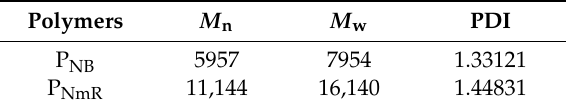
Figure 1. Characterization of fluorescent polymers. ( a ) Absorption spectra of the fluorescent polymers; ( b ) temperature-dependent for the fluorescent polymers in aqueous solution (500 nm, 0.5% w / v ); and ( c ) FT-IR results of the fluorescent polymers. Table 1. GPC results of fluorescent